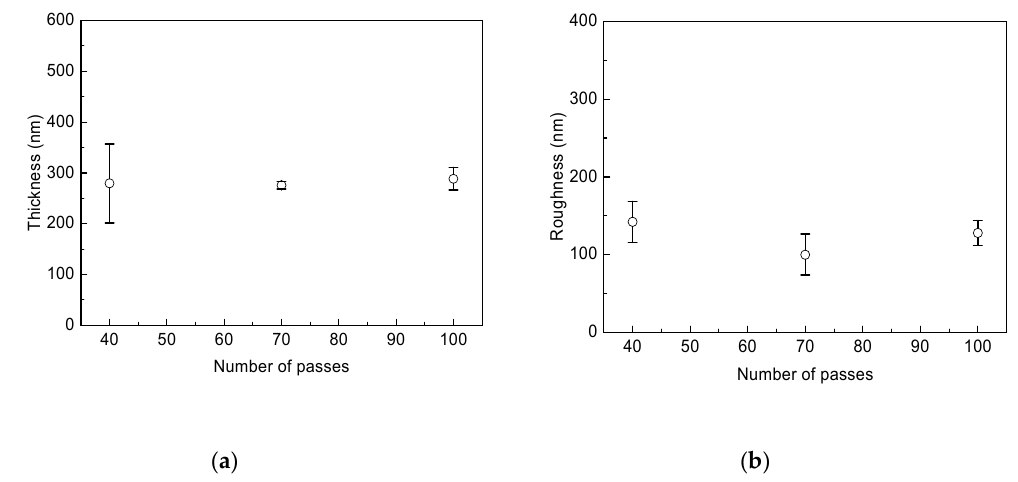
Figure 8. Measured ( a ) thickness and ( b ) roughness of spray-on perovskite films deposited on the substrates kept at 150 °C, at various number of spray passes. Coatings 2017 , 7 , 42